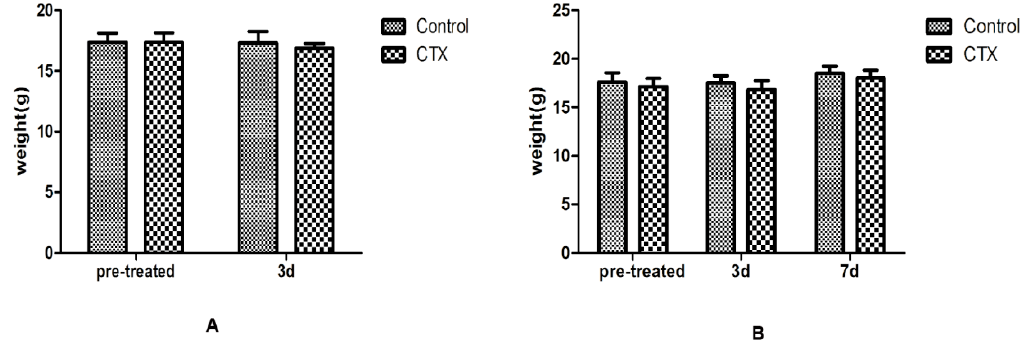
Figure 1. A single dose of Cyclophosphamide injection did not change body weight at different time points. ( A ) Three days after CTX treatment; ( B ) Seven days after CTX treatment. The results show the means ± SD.